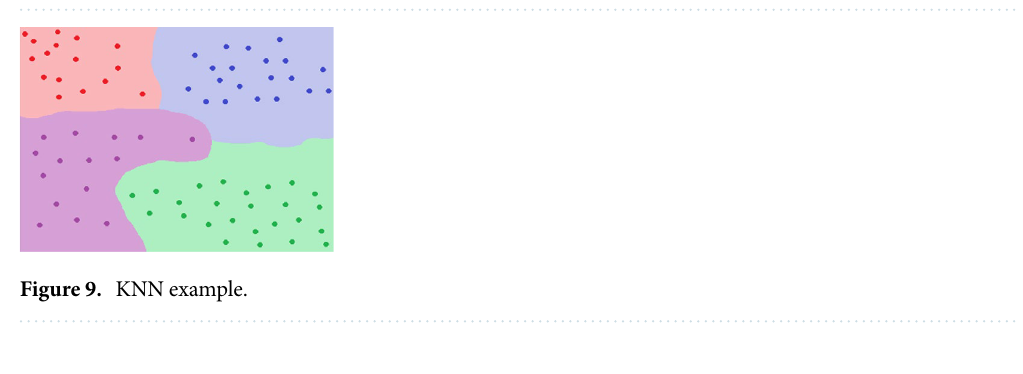
Figure 8. Entropy analysis. (1) Black and White image. (2) Histogram of the image.